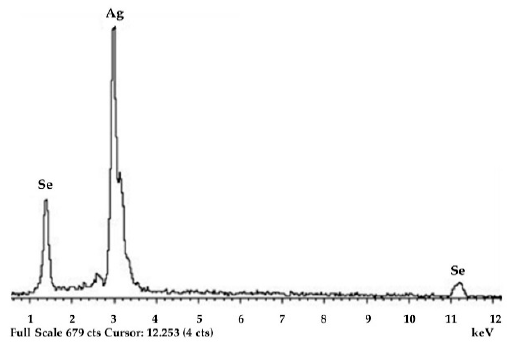
Figure 14. Spectrum associated with the Se-Ag phase (phase 1). Table 9. Semi-quantitative analysis of the Se-Ag phase (phase 1). Element Weight, % Atomic, %